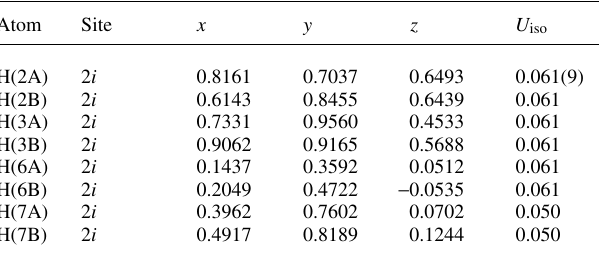
Table 2. Atomic coordinates and displacement parameters (in Å 2 )